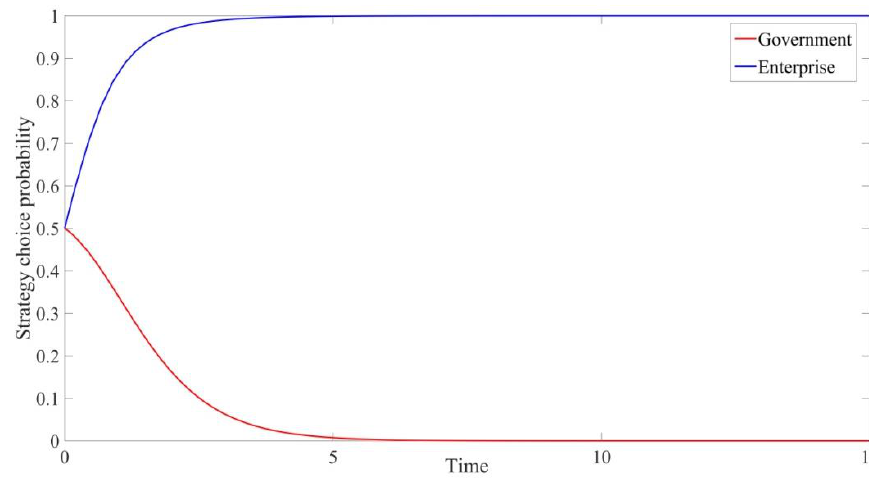
Figure 8. Simulation results of the partial equilibrium point (1,0).